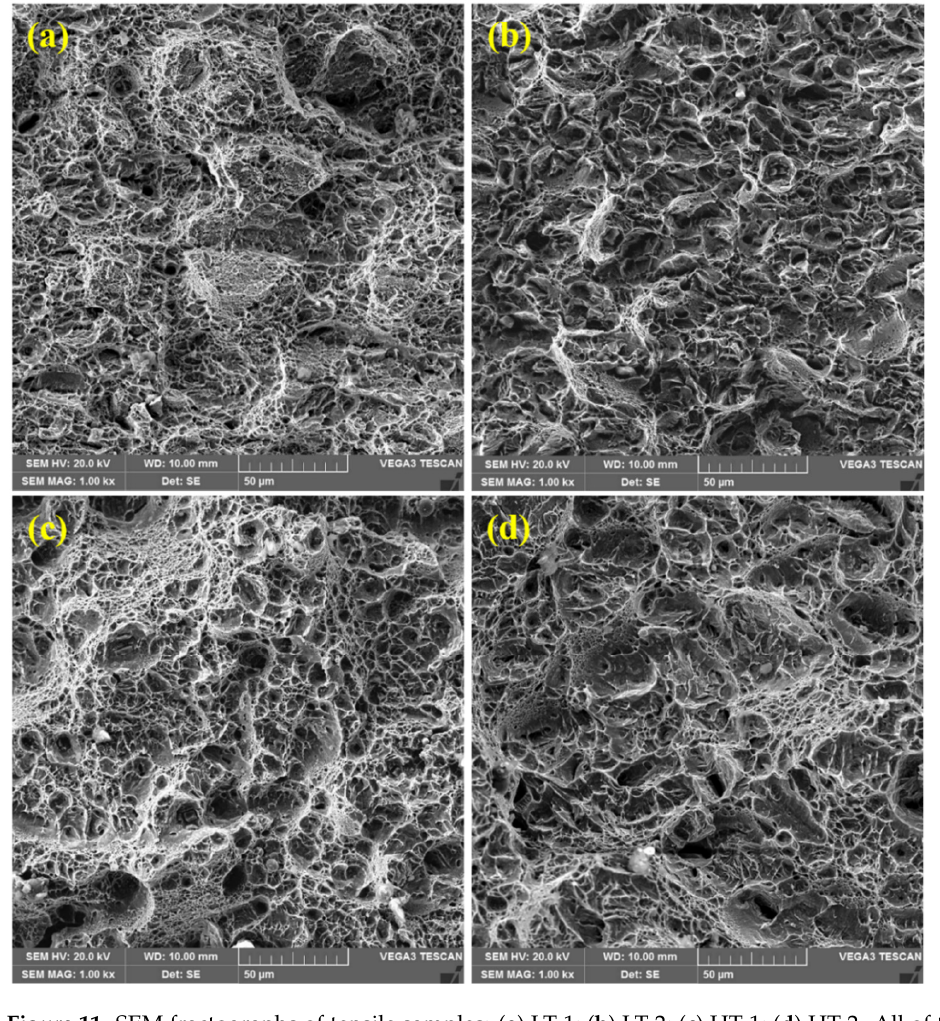
Figure 11. SEM fractographs of tensile samples: ( a ) LT-1; ( b ) LT-2; ( c ) HT-1; ( d ) HT-2. All of these samples exhibit ductile fractures.